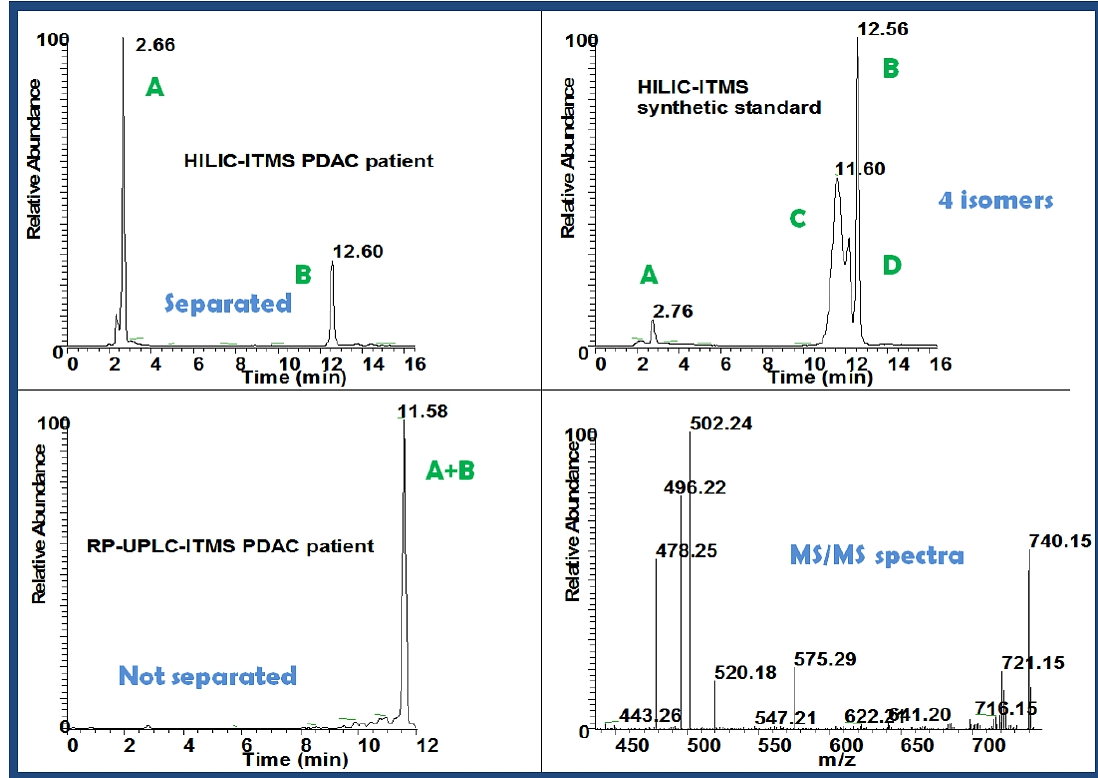
Figure 4. Extracted chromatograms of the positive ion m/z 758 and the corresponding MS/MS spectra from the human plasma sample of a PDAC patient and from a commercial authentic standard.